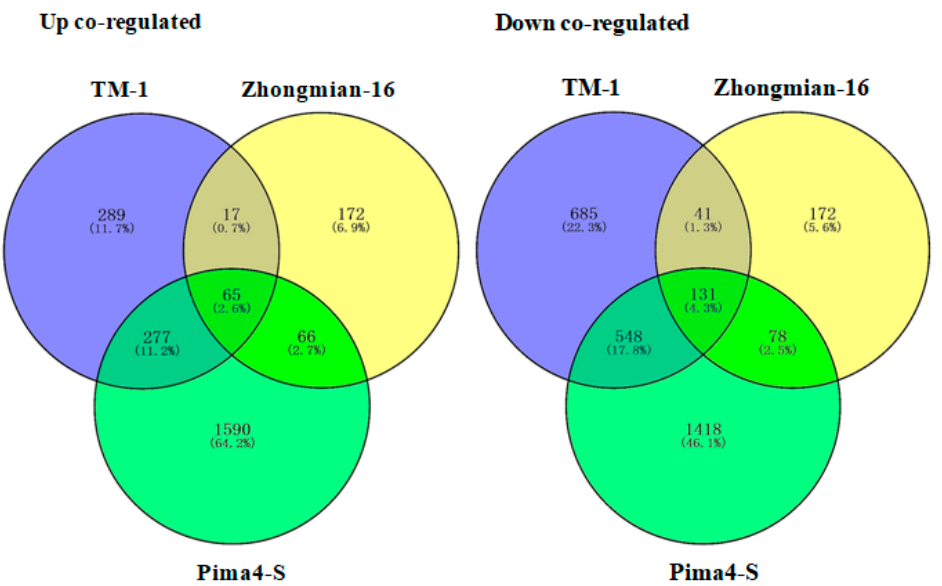
Figure 1. Di ff erential gene expression (DEGs) in three cotton species. Figure 1. Differential gene expression (DEGs) in three cotton Figure 1. Differential gene expression (DEGs) in three cotton species.